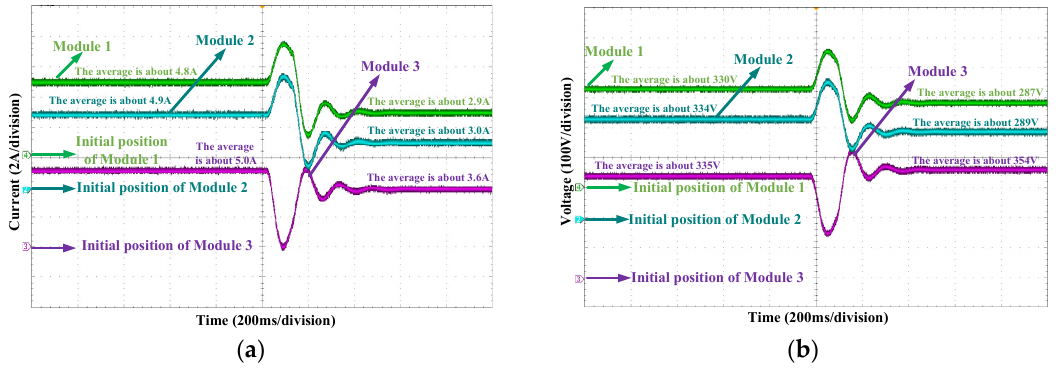
Figure 15. Experimental results of combined converter 1: ( a ) input current of the modules and ( b ) output voltage of the modules.